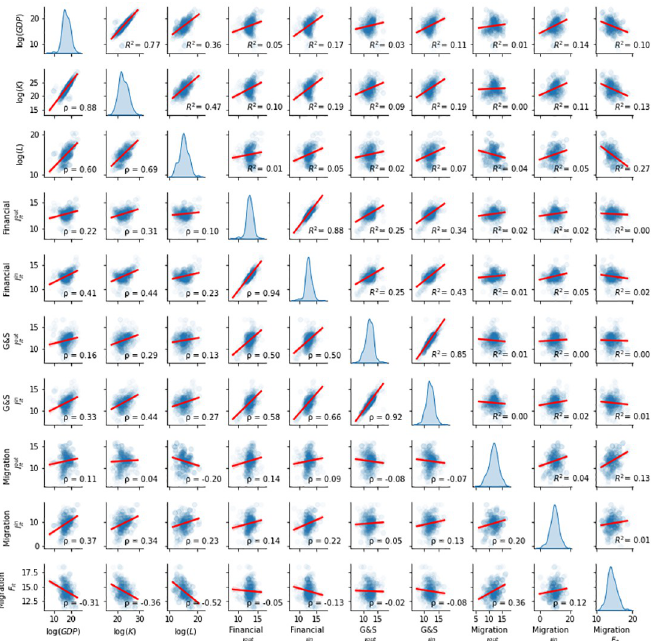
Fig 2. Pairwise distribution matrix for economic output (log( GDP )), capital (log( K )), labor (log( L )) and the developed social capital indicators: Inwards/outwards information capital ( I in / I out ), and favour capital F for the financial, goods and services, and migration networks. Each observation corresponds to one country and year. Spearman correlations ( ρ ) are shown in the lower triangular matrix, while the R 2 of a linear regression model with intercept is shown in the upper triangular